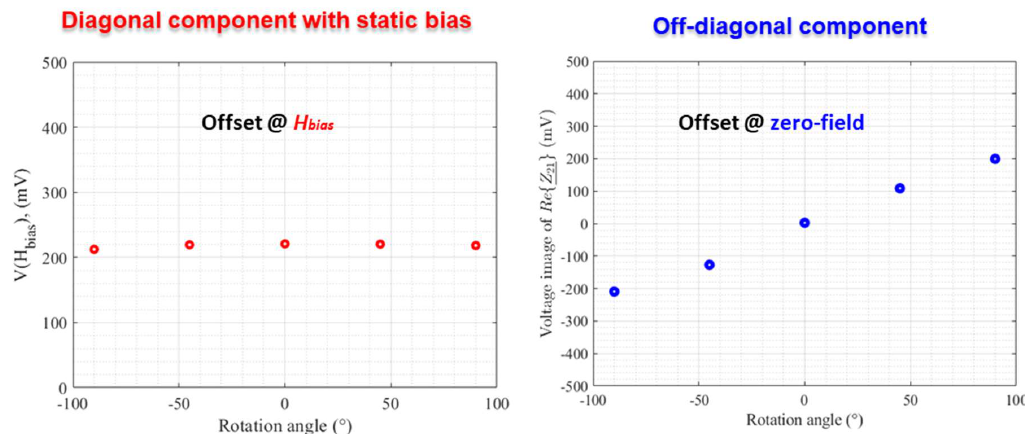
Figure 7. Change of the offset of the diagonal and off-diagonal components as a function of the rotation angle.